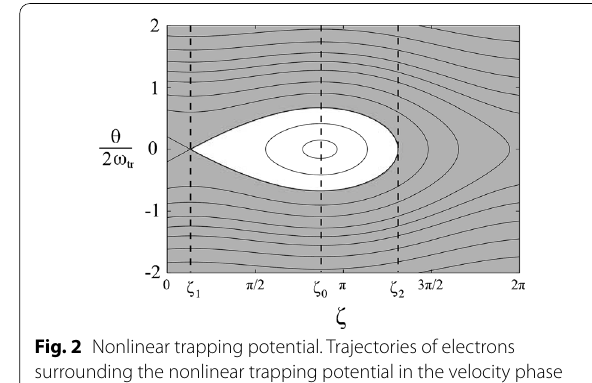
ω t χ/ √ γ . When the right-hand side of (41) where ω tr = 0 , the first-order resonance condi- is zero, i.e., d ζ/ d t = d 2 ζ/ d t 2 , the second-order reso- (42) is zero, i.e., d θ/ d t = S 1 , the second- nance condition is satisfied. When | | ≤ order resonance condition is satisfied at two phase angles ζ 0 closer to π and ζ 1 closer to 0. The point (ζ 0 , 0 ) in the ζ θ phase space is a stable equilibrium point around − which resonant electrons rotate with the angular fre- quency ω tr , as shown in Fig. 2. The other point (ζ 1 , 0 ) is an unstable equilibrium point called a saddle point. The separatrix between trapped and untrapped resonant elec- trons originates from this saddle point. Eliminating the time variable t from (41) and (42) and integrating them by ζ and θ , we obtain θ plane. which is the equation for trajectories in the ζ − Substituting the values at the saddle point into (43), we obtain an equation for the separatrix for ζ 1 < ζ < ζ 2 , where ζ 2 is the phase of the separatrix 0 . The size of the trapping potential changes crossing θ = S 1 1 ) . In terms of the parallel as a function of S ( − ≤ ≤ velocity v , electrons near the resonance velocity V R can (cid:31) be trapped and oscillate around V R with the maximum 2 ω tr / k for width of the trapping velocity given by V tr = S 0 . = The separatrix between the trapped electrons and untrapped electrons plays a critical role in determining the wave growth and damping. The trapped electrons with (π , 0 ) forming trajectories S 0 oscillate around (ζ , θ) = = symmetric around the wave magnetic field. The symmet- ric trajectories indicate that the trapped electrons received